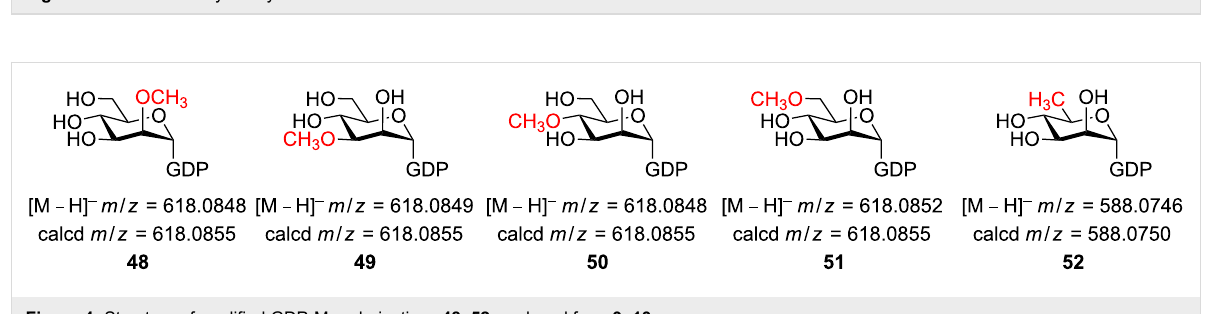
Figure 4: Structure of modified GDP-Man derivatives 48 – 52 produced from 9 – 13 .